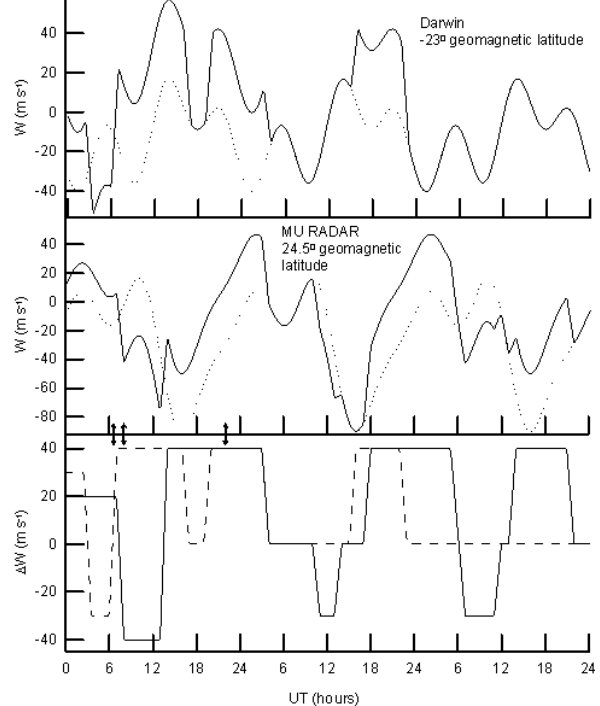
Fig. 11. Diurnal variations of the meridional HWW90 neutral wind, W, the correction, 1 W, of W during 25–27 August 1987 (when the original value of W is changed to W+ 1 W). The values of 1 W shown in the low panel are used in the Northern Hemisphere above the geomagnetic latitude of 24 ◦ (solid line) and in the Southern Hemisphere below the geomagnetic latitude of − 24 ◦ (dashed line), while 1 W=0 at the geomagnetic equator. A square interpolation of 1 W is employed between − 24 ◦ and 0 ◦ and between 24 ◦ and 0 ◦ . The modeled meridional uncorrected HWW90 (dotted lines) and corrected (solid lines) neutral winds at 300km are shown in the middle and top panels over the MU radar and over the Dar- win ionosonde station, respectively. The meridional HWW90 wind is directed northward for W > 0 and southward for W < 0. The start times of the sudden commencement (06:58 UT on 25 August), main phase (08:00 UT on 25 August) and recovery phase (22:00 UT on 25 August) of the geomagnetic storm are indicated by the